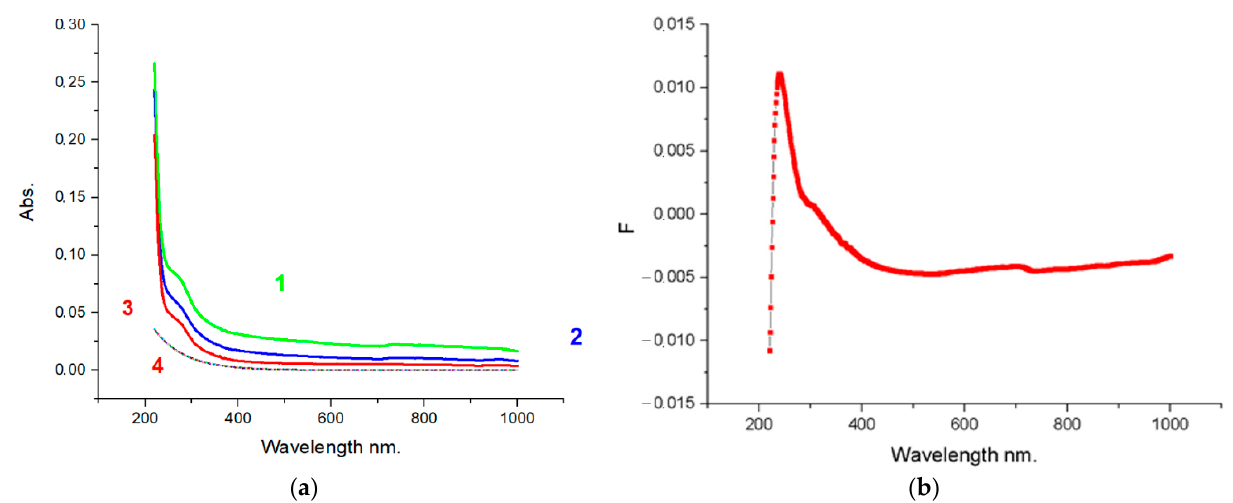
Figure 8. UV ‐ VIS spectra of FLG nanosheets. ( a ) UV ‐ VIS absorption spectra in FLG nanosheets. 1—glucose, 2—starch, 3—cellulose, 4—background spectrum. ( b ) Graph for FLG nanosheets from starch with the background subtracted on residual hydrocarbons that may be present in graphene nanosheets.